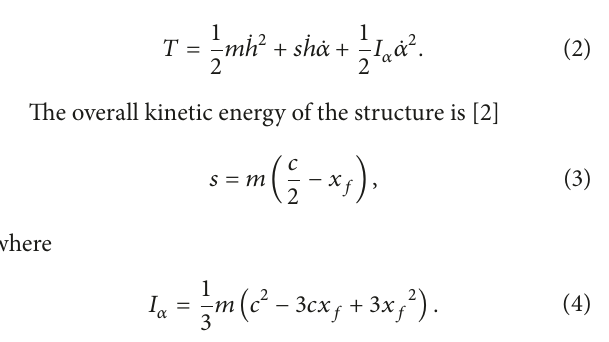
Figure 1: The summarized studies on an aeroelasticity triangle of collar